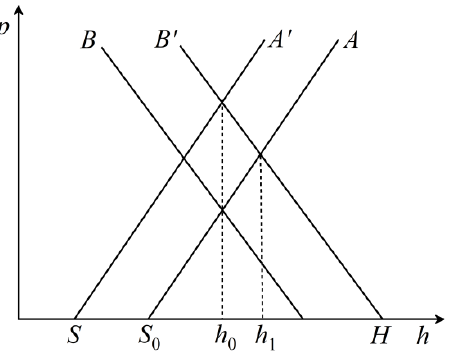
Figure 4. Adjustment reduction principle under the influence of incoming material thickness.